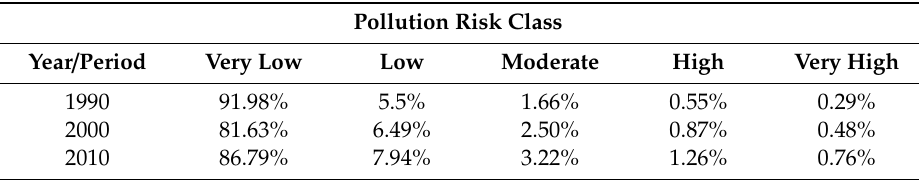
Table 3. Percentage of area per class of pollution risk.